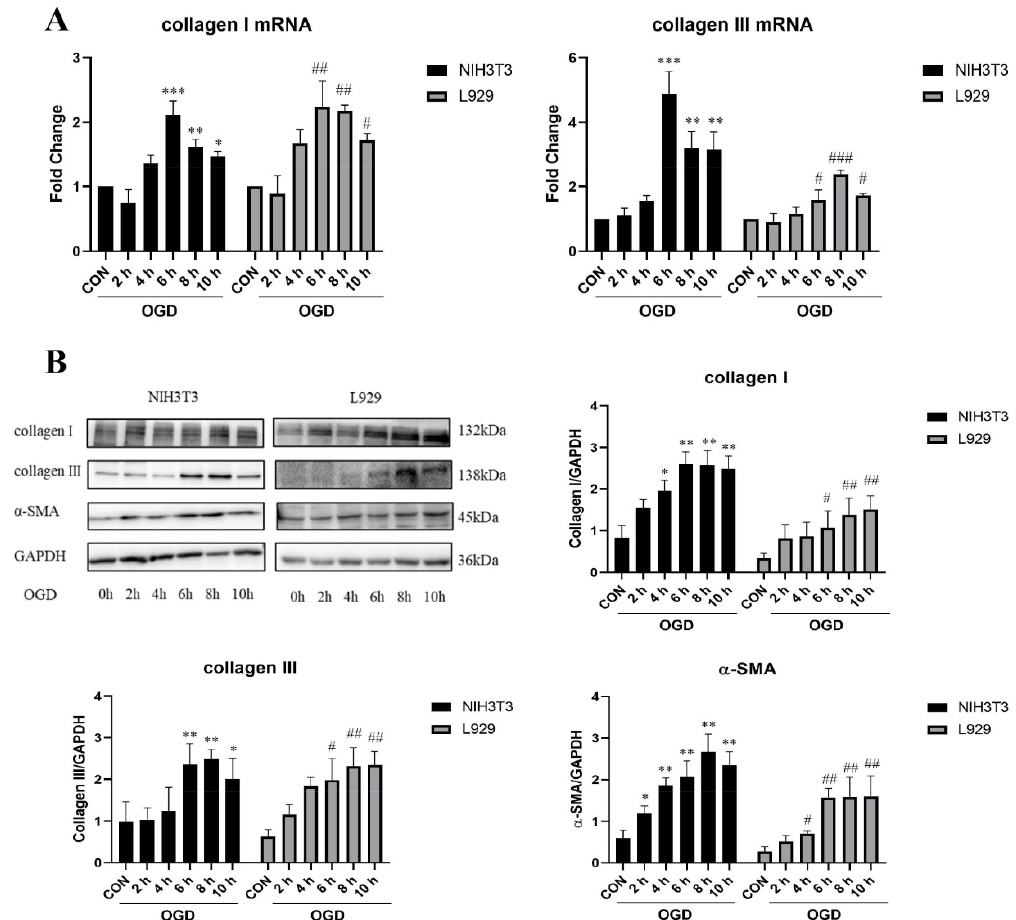
Figure 2. OGD increased collagen expression. ( A ) mRNA expression was estimated by RT-PCR for collagen I and collagen III in NIH3T3 and L929 cells under OGD conditions for 0 h, 2 h, 4 h, 6 h, 8 h, and 10 h. ( B ) Western blot analysis and densitometric analysis of collagen I, collagen III, and α -SMA protein levels in NIH3T3 and L929 cells under OGD conditions for 0 h, 2 h, 4 h, 6 h, 8 h, and 10 h. GAPDH was used as the loading control. OGD—oxygen–glucose deprivation; CON—control. The results are presented as the means ± SDs, and Student’s t -test was used to determine the p -value. * p < 0.05, ** p < 0.01, and *** p < 0.001, compared with CON group in NIH3T3 cells; # p < 0.05, ## p < 0.01, and ### p < 0.001, compared with CON group in L929 cells.